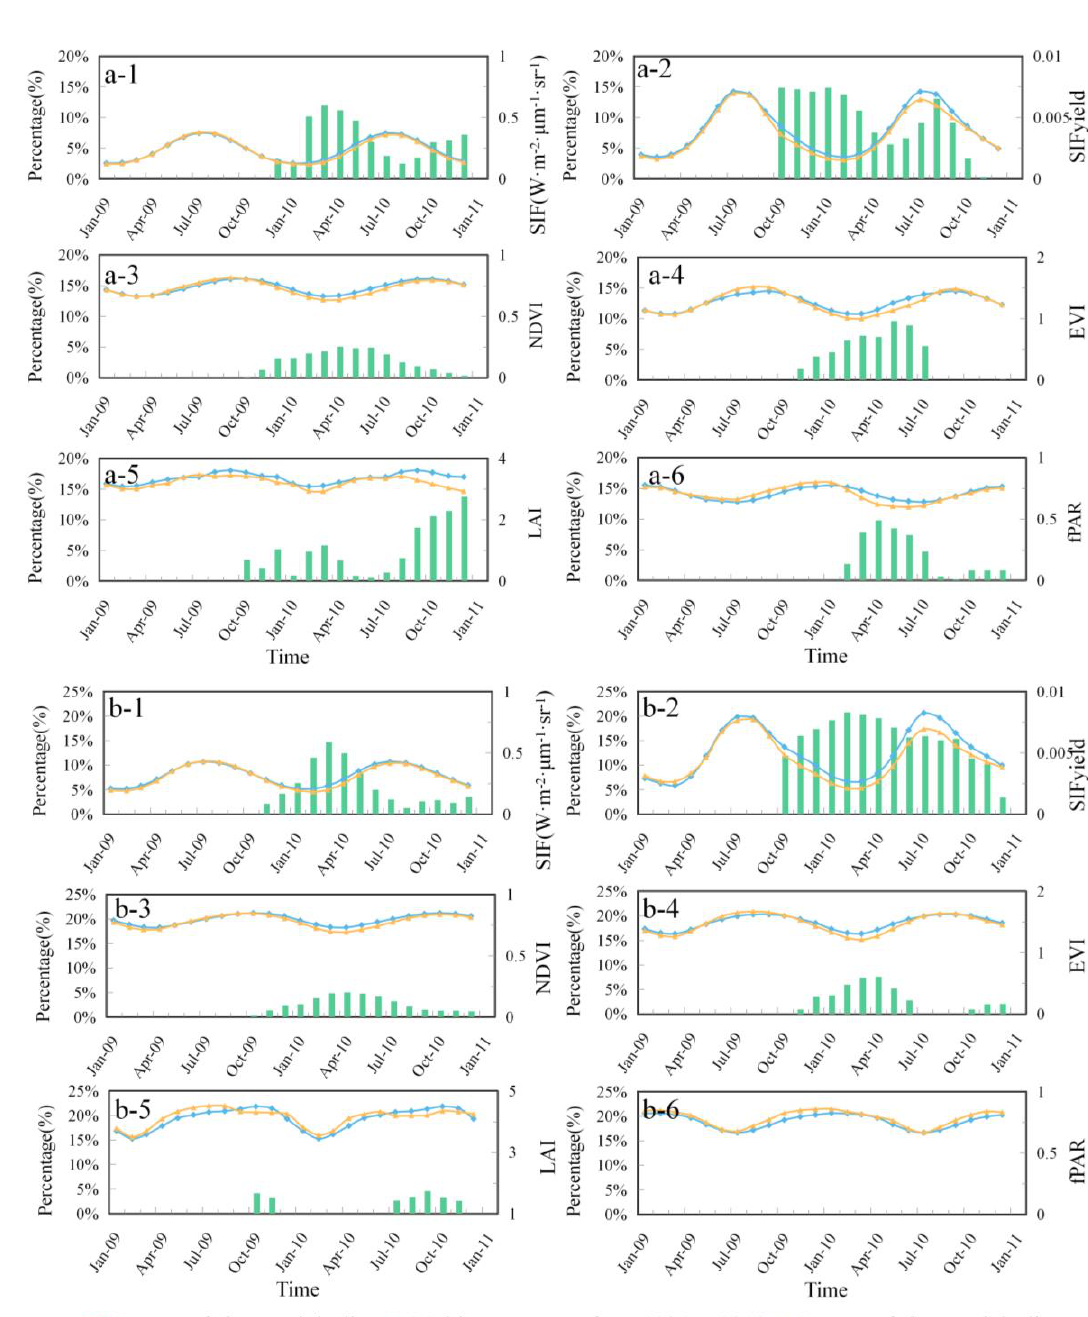
Figure A1. ( a1 – a6 ) The seasonal cycle variation curves of present values and multi-year averages and the abnormal decrease amplitude of the present values from the average values of SIF, SIFyield, NDVI, EVI, LAI, and fPAR, respectively, of the subtropical evergreen broad-leaved forest region in Yunnan province ( b1 – b6 ). The seasonal cycle variation curves of present values and multi-year averages and the abnormal decrease amplitude of the present values from the average values of SIF, SIFyield, NDVI, EVI, LAI, and fPAR, respectively, of the tropical monsoon rainforest and rainforest region in Yunnan province.